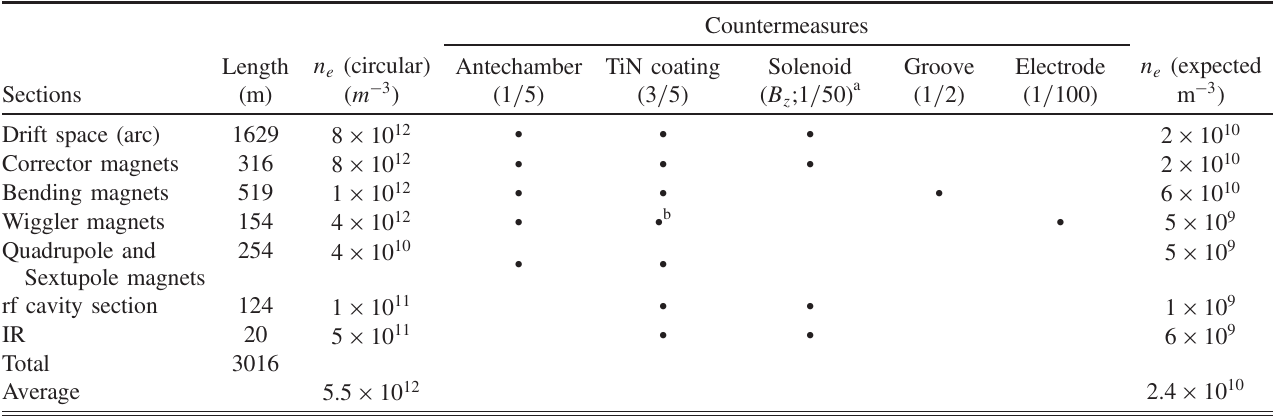
TABLE II. Countermeasures used to minimize the ECE in the SuperKEKB LER. The circular dots indicate the countermeasures applied for each main section in the ring.